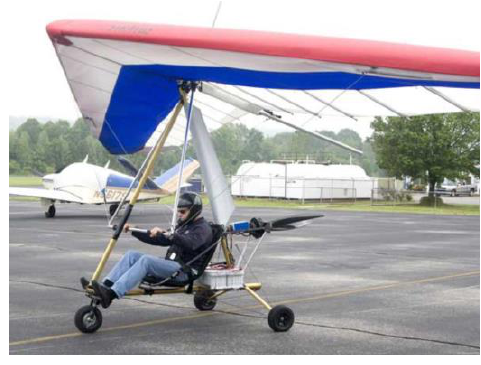
Fig. 5. Motor hang glider ElectraFlyer Trike